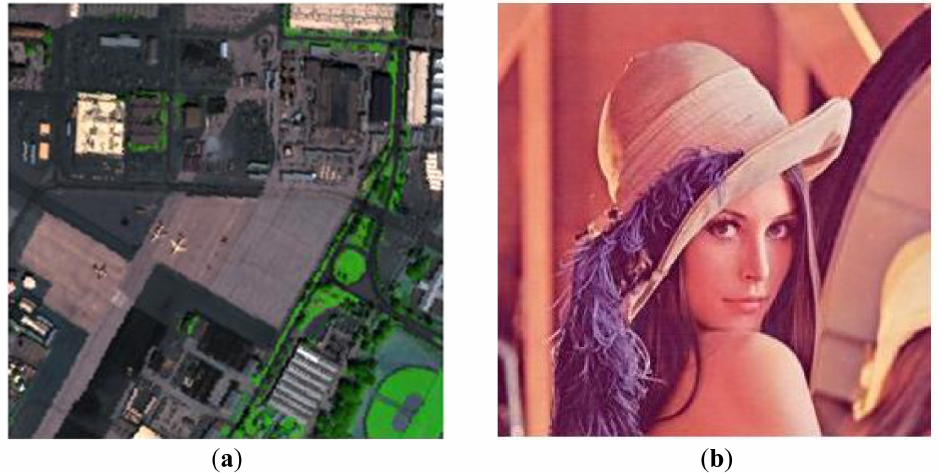
Figure 5. Experimental data: ( a ) pseudo color composites combined of 30th, 70th and 100th band; ( b ) ‘Lena’ test